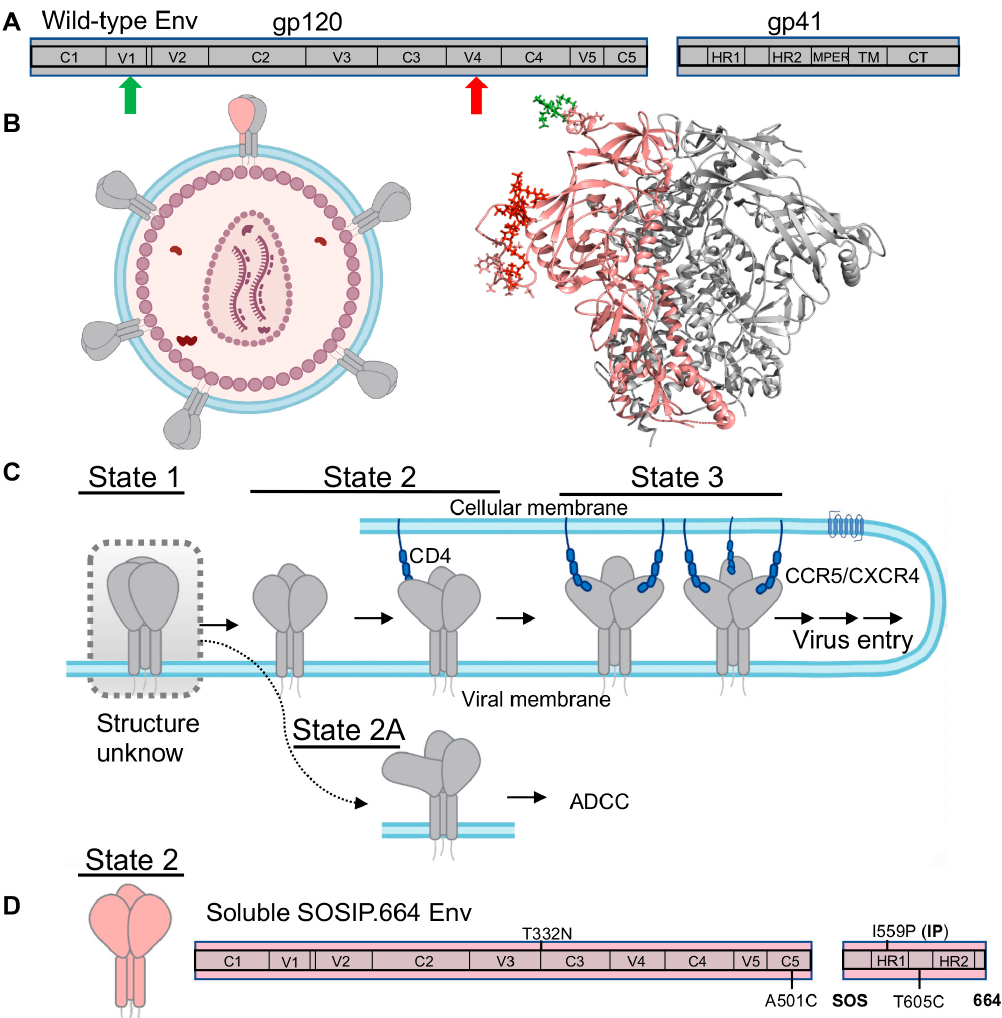
Figure 4. On-path pre-fusion HIV-1 envelope (Env) trimer conformations identified by smFRET imaging. ( A ) Scheme of wild-type HIV-1 Env, noncovalently associated gp120 and gp41 subunits. ( B ) smFRET imaged individual HIV-1 viruses carrying a fluorescently labeled protomer within an Env trimer and elsewhere wild-type trimers. The Cy3/Cy5-labeled protomer (Cy3, green; Cy5, red) is in pink, whereas other wild-type protomers are colored gray. Structure is made based on PDB accessions 4ZMJ and 5FUU. ( C ) Model of Env activation by sequential binding of CD4 receptors. Env dynamically samples three primary conformational states in which State 1 is the predominant one. Upon sequential activation by CD4, Env transits through an asymmetric State 2 to a completely open State 3 (two- or three-CD4-bound trimer). State 2-Env is a single CD4-bound asymmetric trimer, in which the CD4-bound protomer adopts State 3 and the neighboring free protomers adopt State 2. State 2A is an off-path conformation that is highly vulnerable to antibody-dependent cellular cytotoxicity (ADCC). Following CD4 activation, the binding of coreceptors CCR5/CXCR4 lead to virus entry, which smFRET has not informed. ( D ) Vaccine candidates based upon soluble SOSIP.664 Env trimer resemble State 2, consisting of three State 2 protomers. The design of soluble SOSIP.664 Env is illustrated in the schematic. Results from ( D ) infer that State 1 Env ( C ) is structurally